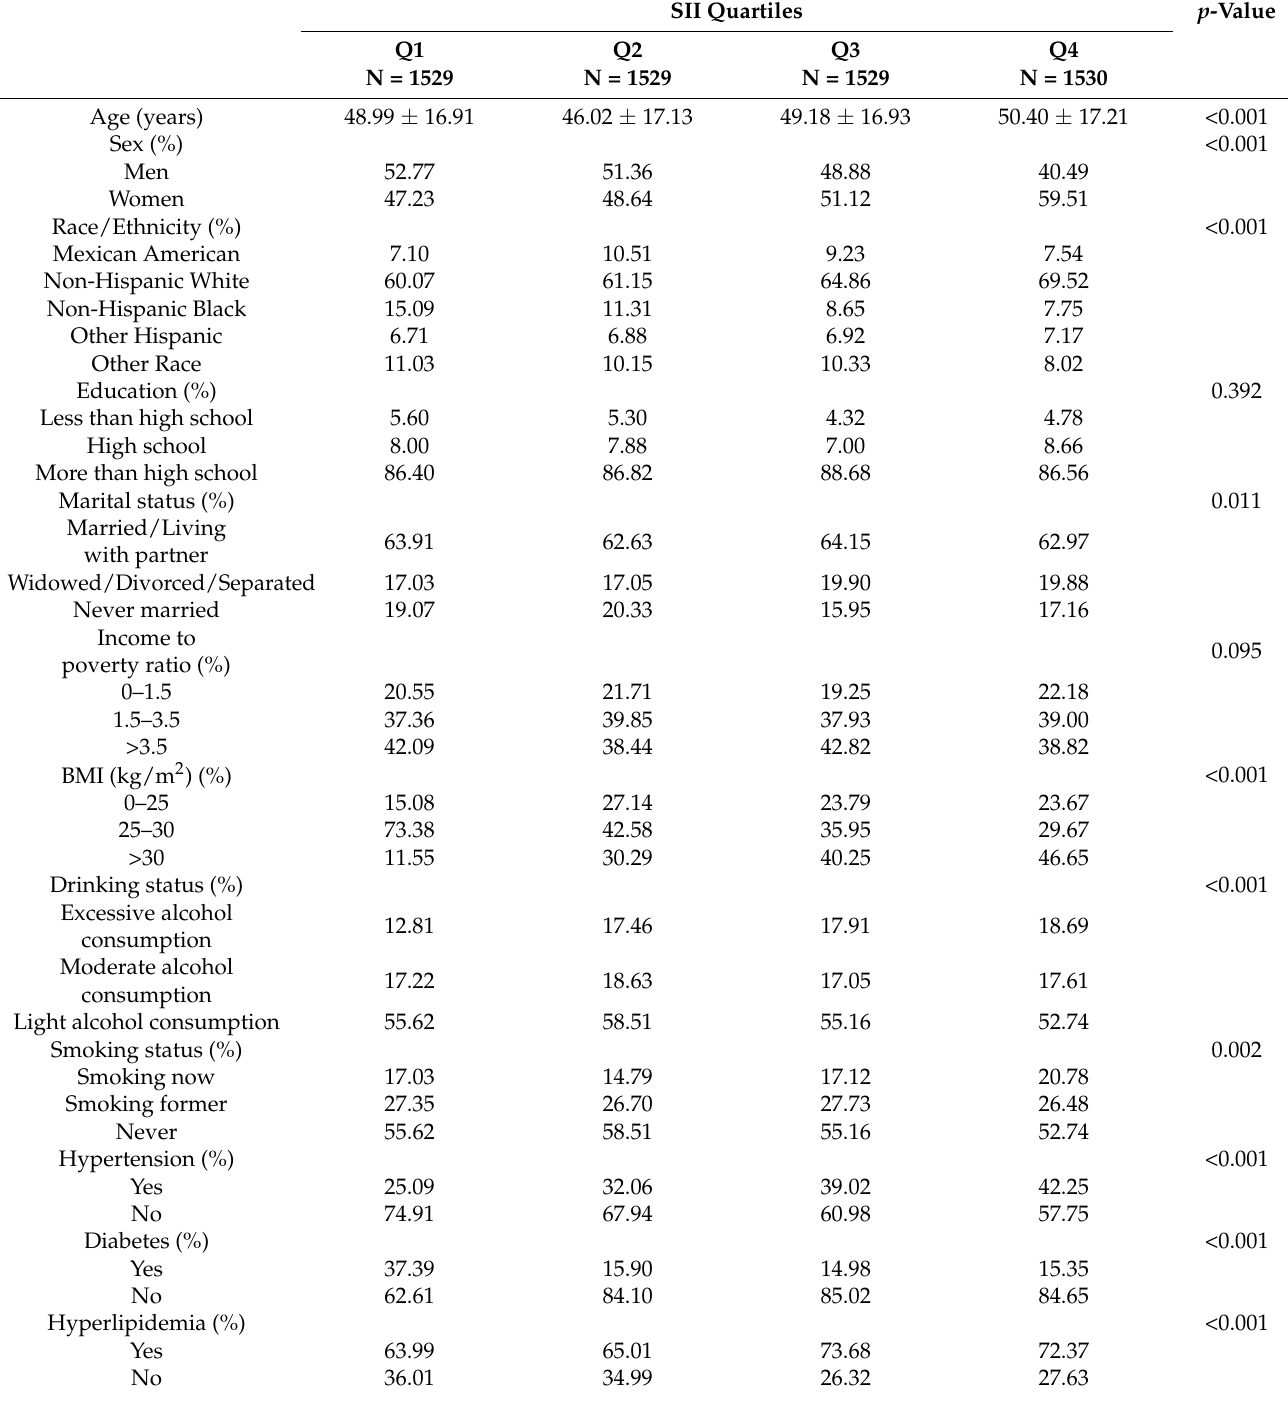
Table 2. Weighted characteristics of the study population based on SII